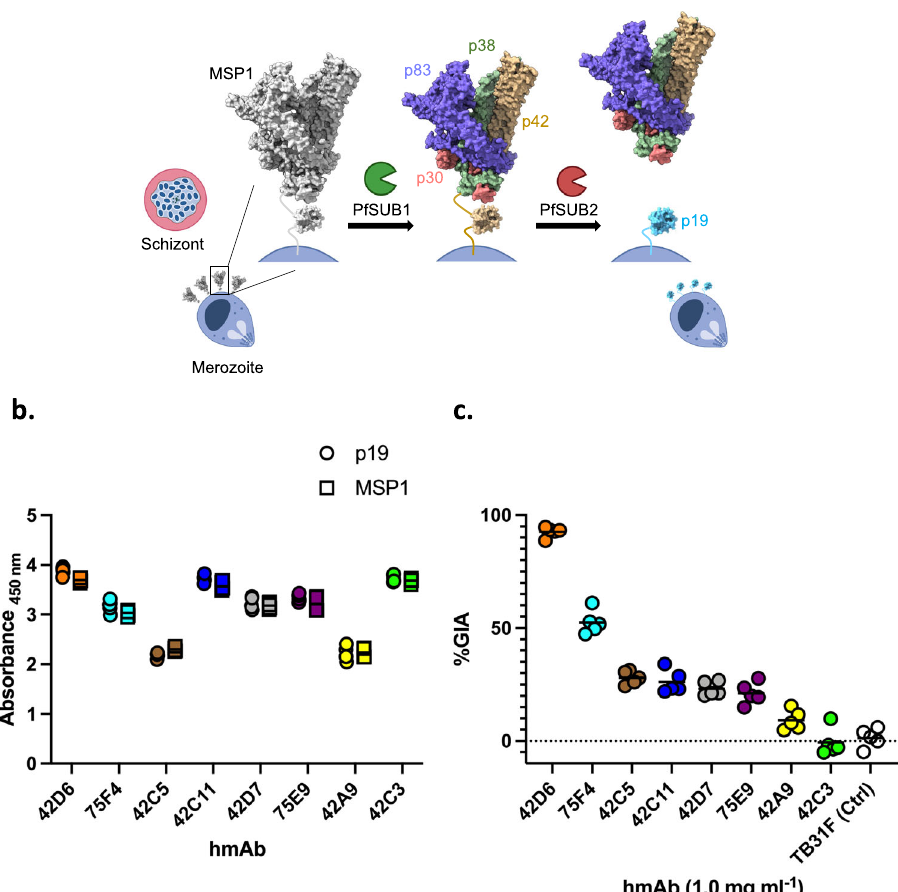
Fig.1|FunctionalcharacterizationofpotentneutralizingAbsandhigh-af fi nity non-neutralizing Abs isolated from malaria-exposed individuals. a Assembly andprocessingoftheMSP-1.The fi gurewascreated using structureofMSP-1(PDB ID: 6ZBF, https://www.rcsb.org/structure/6ZBF) in ChimeraX (https://www.rbvi. ucsf.edu/chimerax)andBioRender. b ELISAshowingbindingoftheeighthmAbsto